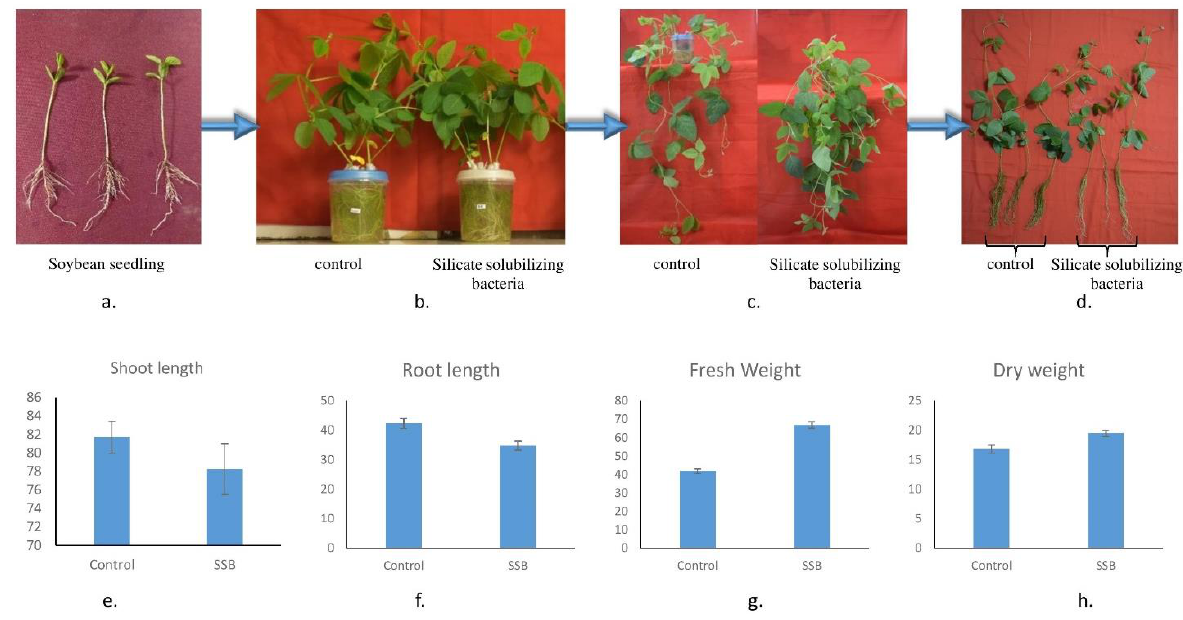
Figure 4. Comparison of control and LR6-treated plant. The 7-day seedlings ( a ) were transferred to a customized hydroponic system ( b ), and the difference was visualized after 30 days ( c , d ). Comparison of root, shoot length and fresh weight and dry weight of control vs. silicate-solubilizing bacteria-treated plants ( e – h ).